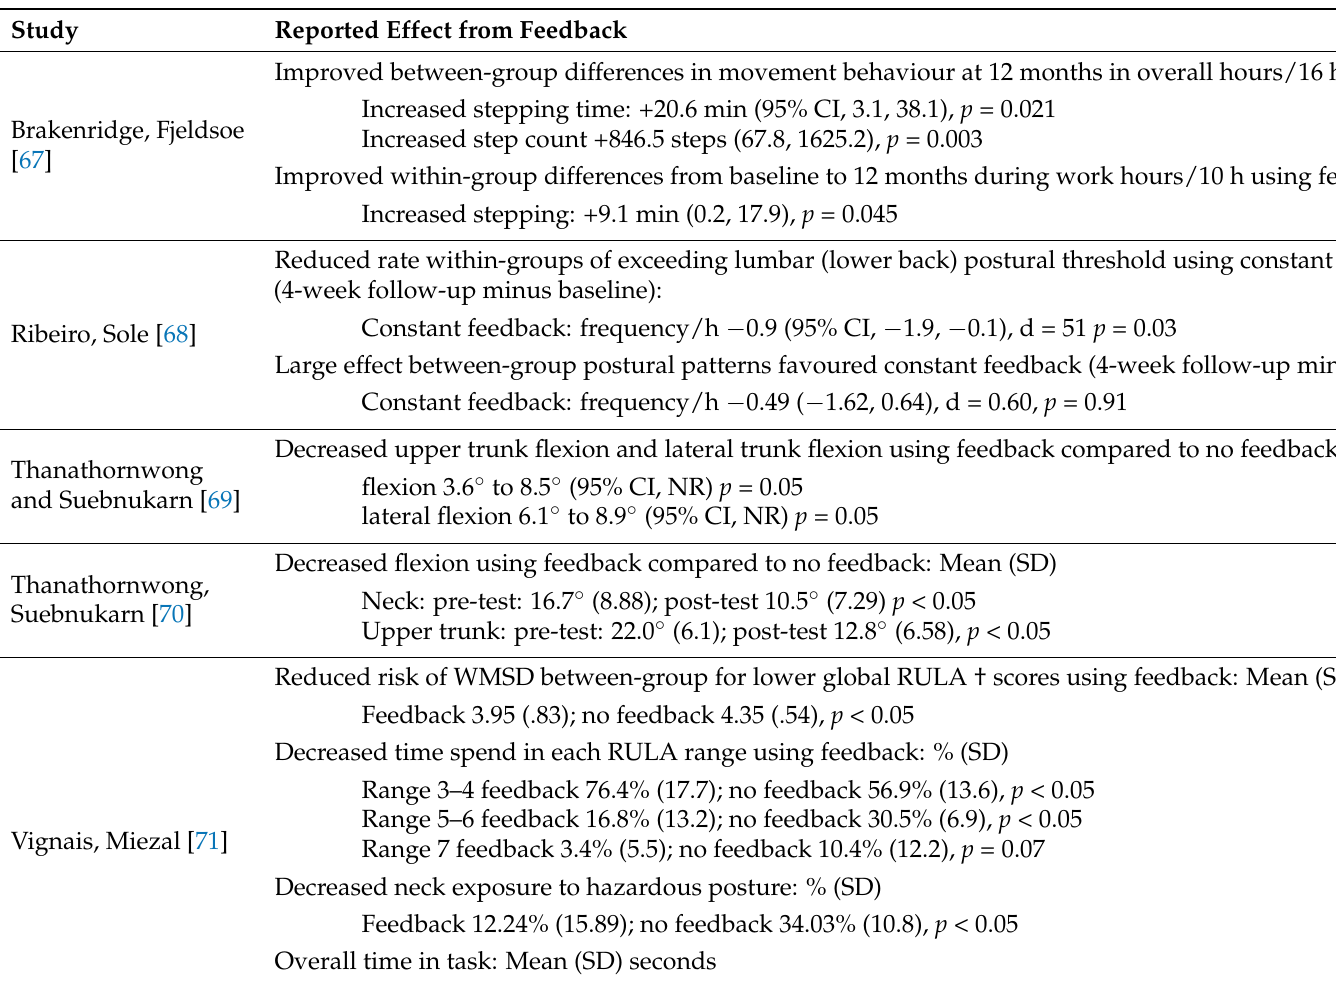
Table 3. Effect of wearable inertial sensor technology (WIST) feedback on participant outcomes in each of the included